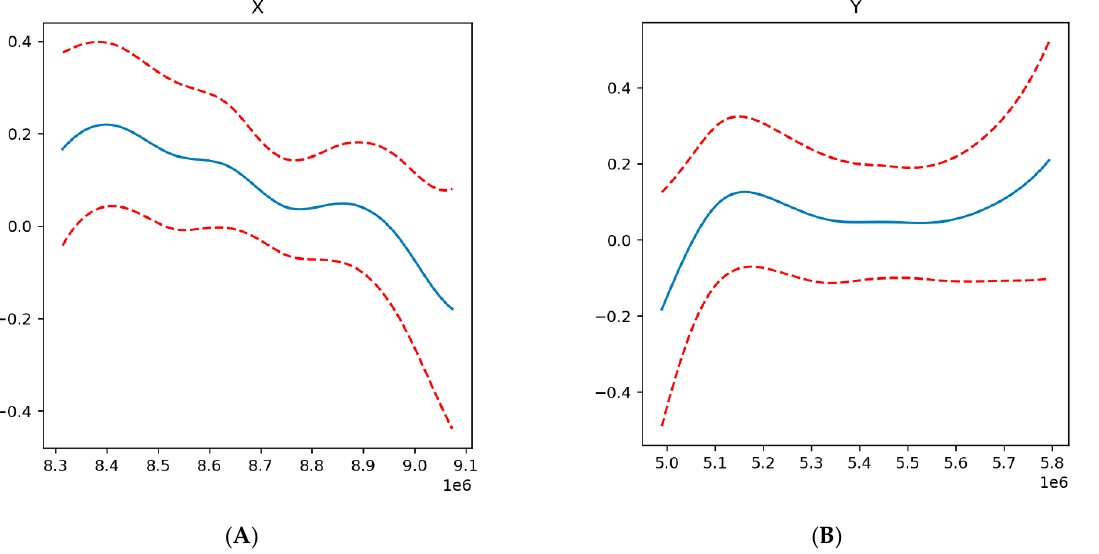
Figure 16. Dependence of rill erosion density on geographical location: ( A )—longitude (m), ( B )—latitude (m).